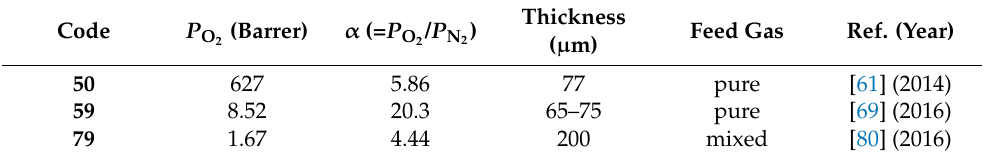
Chart 6. Chemical structures of the membrane polymers in Figure 9 (PIs in 2020). Table 7. Categorization and detailed data for the membrane polymers in Figure 9 (PIs in 2020). Code